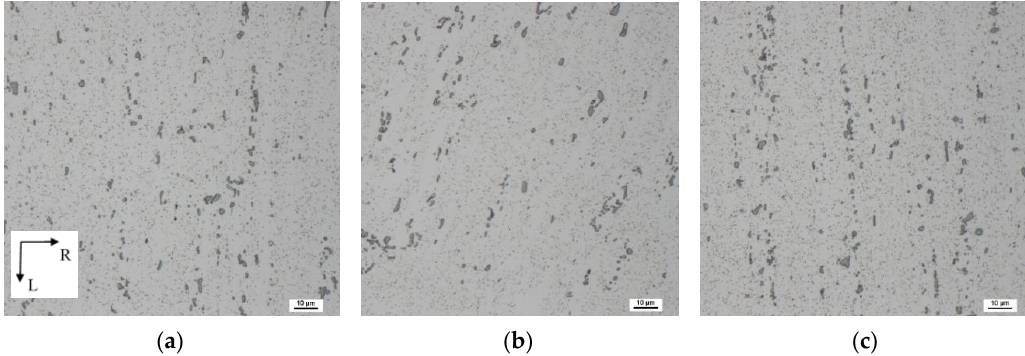
Figure 8. Electron micrographs of the ECS material taken on LR sections: ( a ) left surface region; ( b ) central region; ( c ) right surface region. Dix – Keller etching was used.